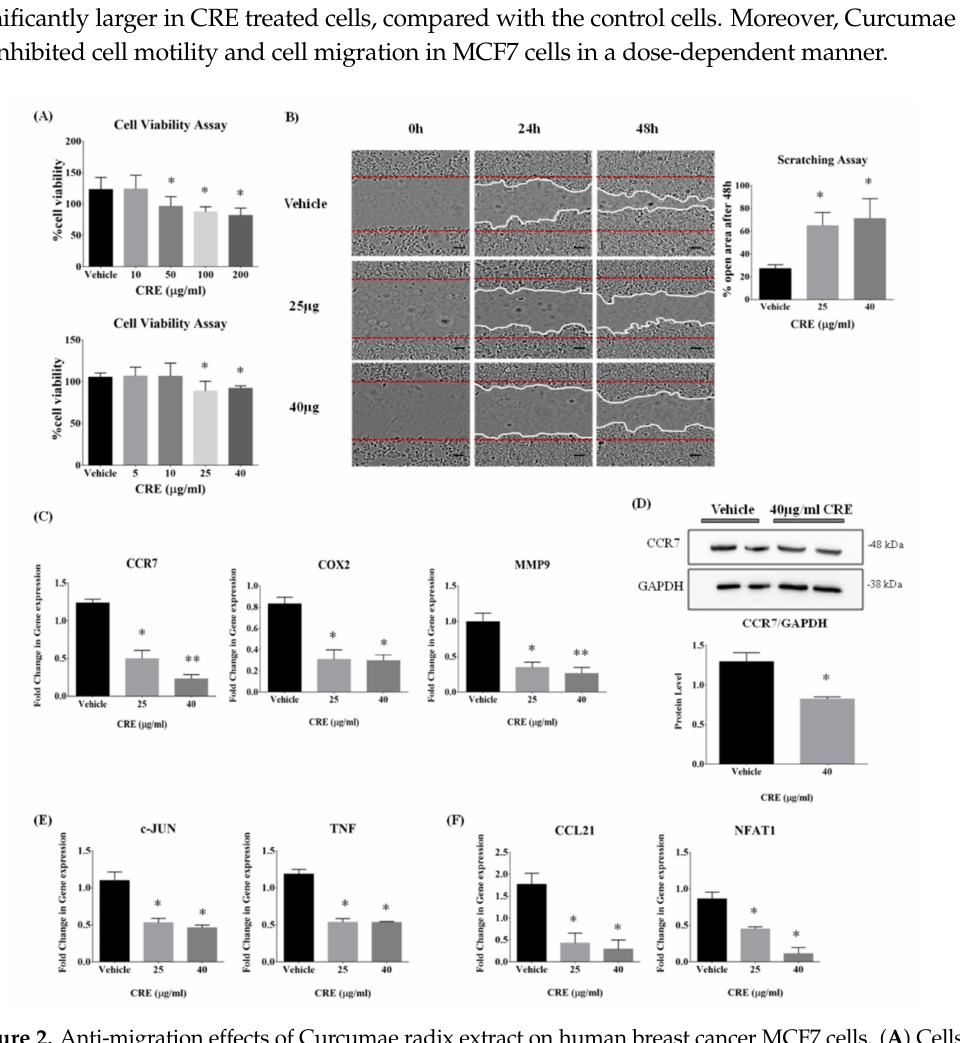
Figure 2. Anti-migration effects of Curcumae radix extract on human breast cancer MCF7 cells. ( A ) Cells were incubated with broad and narrow range of CRE concentrations and cell viabilities were measured by XTT assay at 72 h. Concentrations up to 25 µ g/mL Curcumae radix extract did not significantly